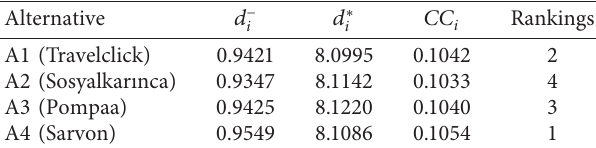
Table 13: Weighted normalized fuzzy decision matrix 􏽥 V